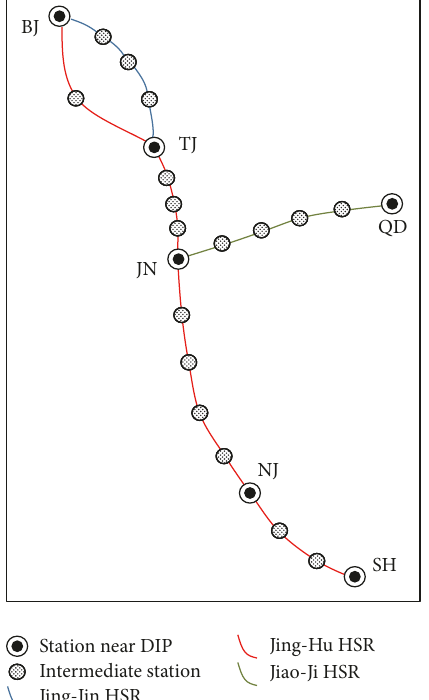
Figure 13: Topological structure of the case study.